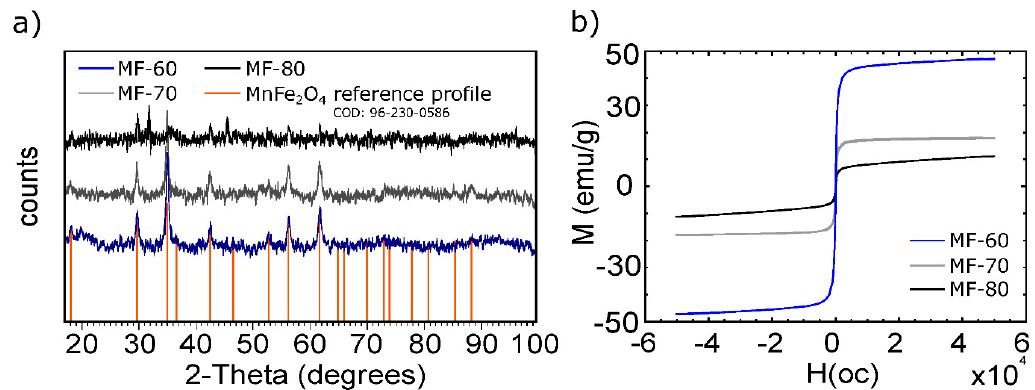
Figure 1. MnFe 2 O 4 characterization. ( a ) XRD patterns, ( b ) magnetic hysteresis loops (300 K).